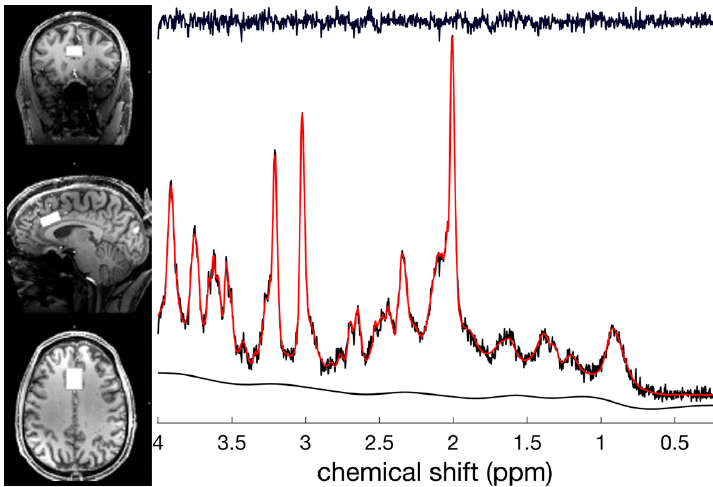
Figure 3. Magnetic resonance spectroscopy (MRS) voxel placement in the dorsal anterior cingulate cortex (dACC) and representative spectra. The 7 Tesla (7T) spectroscopy offers significant advantages, including more accurate assessments of glutamate and glutamine.